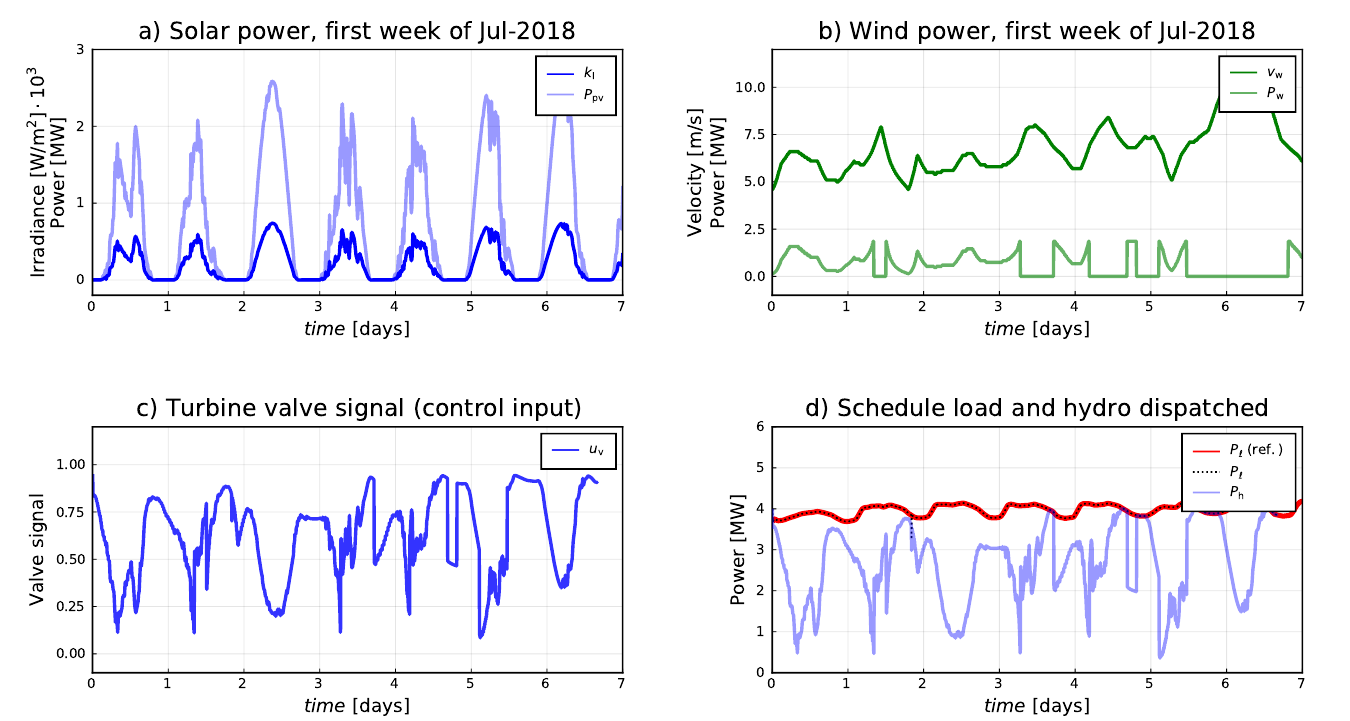
Figure 12. Setpoint tracking of scheduled load using real measurements for solar power, wind power, and consumer